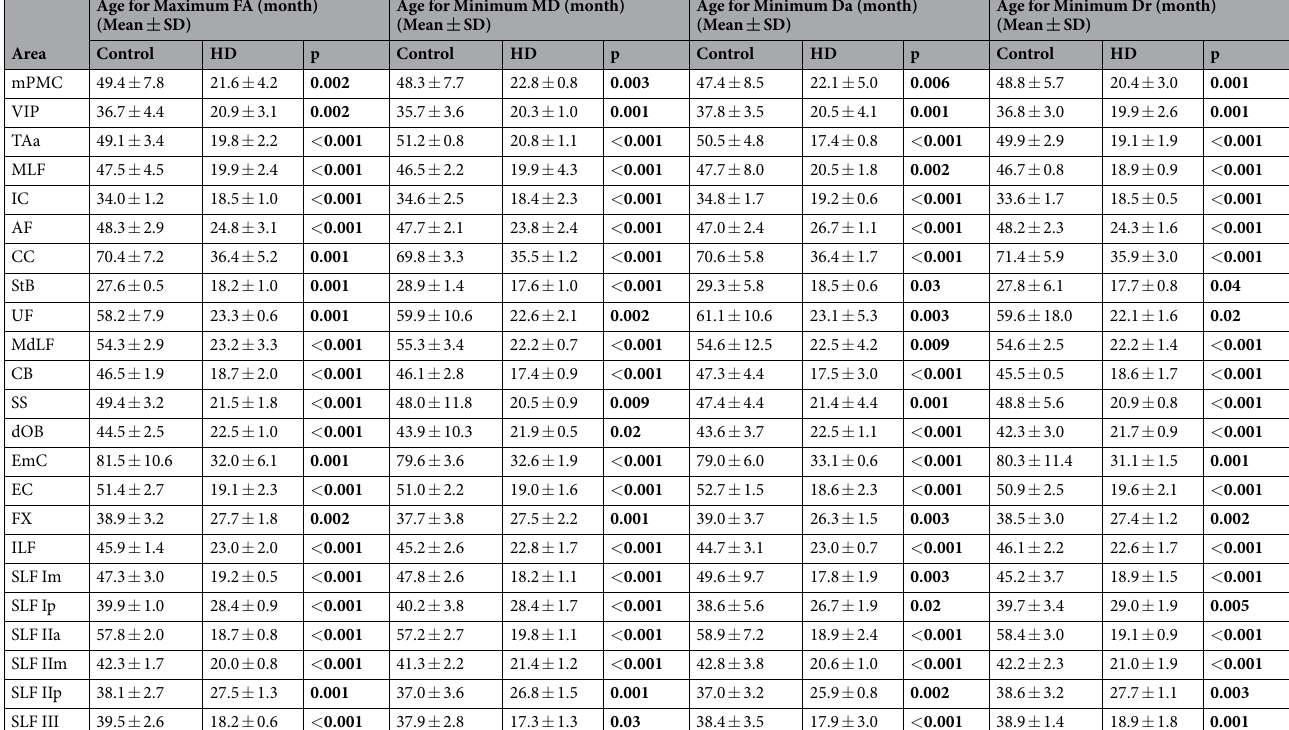
Table 1. Group difference in age for the minimum/maximum DTI-derived measures based on analysis of the Poisson model and TBSS. These data were tested as significant group difference with independent t-test using FDR correction with q value 0.05. SD: standard derivation. FA: fractional anisotropy; MD: mean diffusivity; Da: axial diffusivity; Dr: Radial